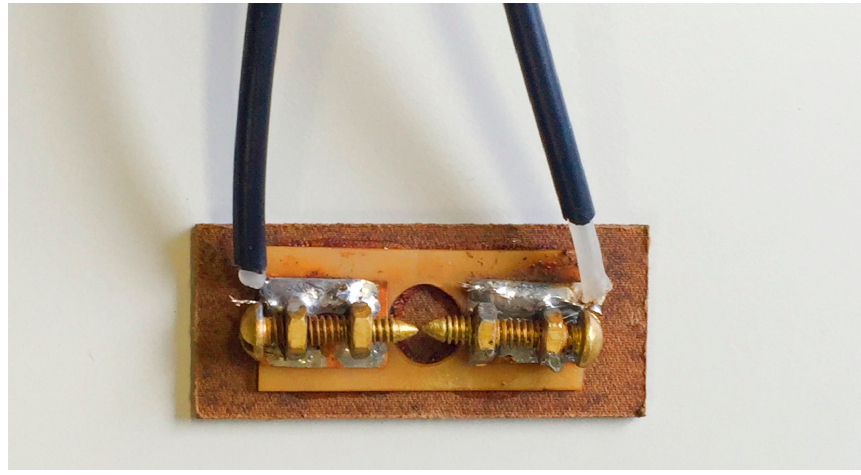
Figure 3. Electrodes used to generate PDs.